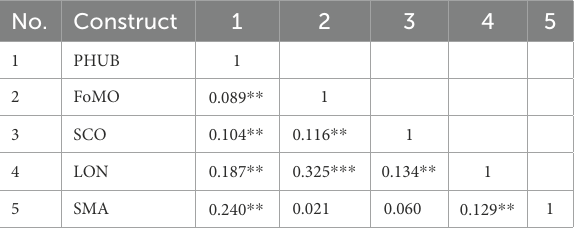
TABLE 2 Correlation among key variables.